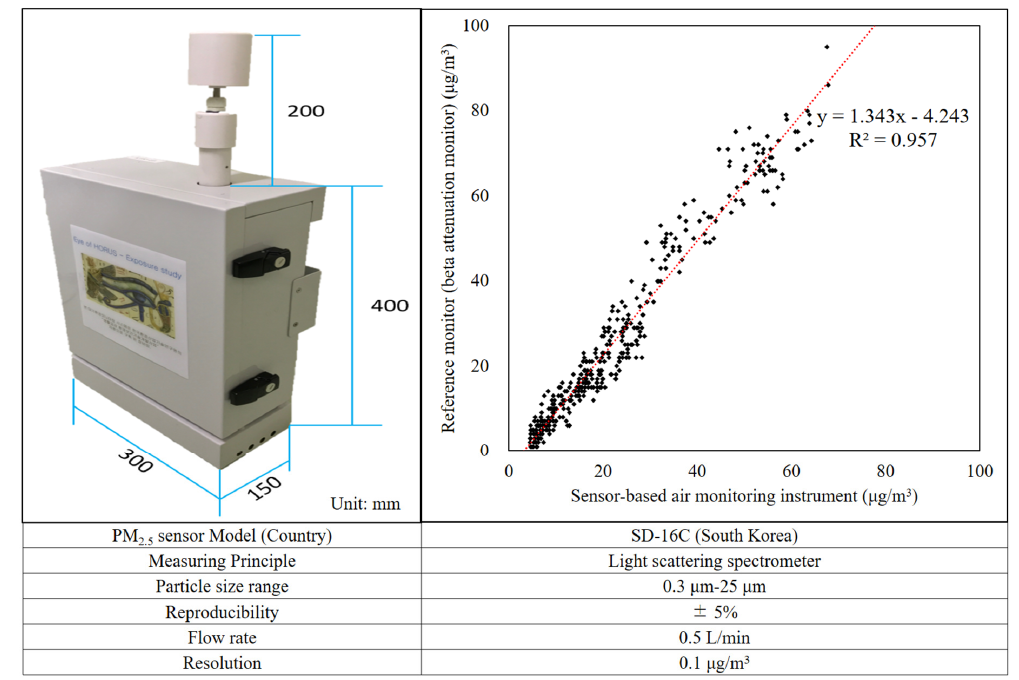
Figure 2. Specification of sensor-based air monitoring